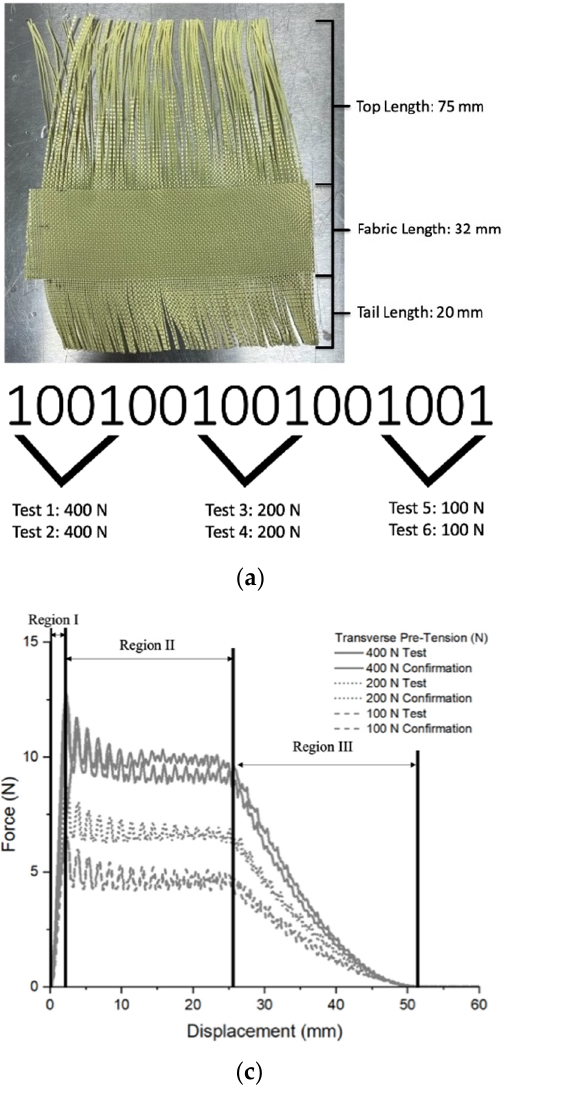
Figure 5. ( a ) Yarn pull ‐ out fabric specimen ( b ) relaxation response; pull ‐ out force–displacement re ‐ sponse of As ‐ received Kevlar ® S706 fabric with 600 denier KM2+ yarn ( c ) weft direction ( d ) warp